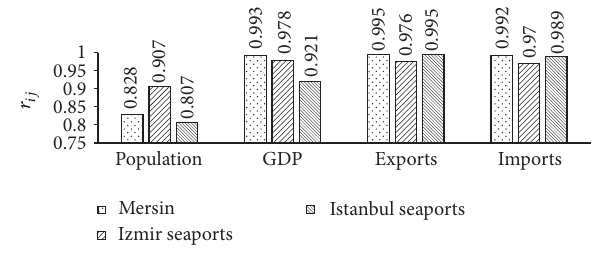
Figure 3: Results of the CAM